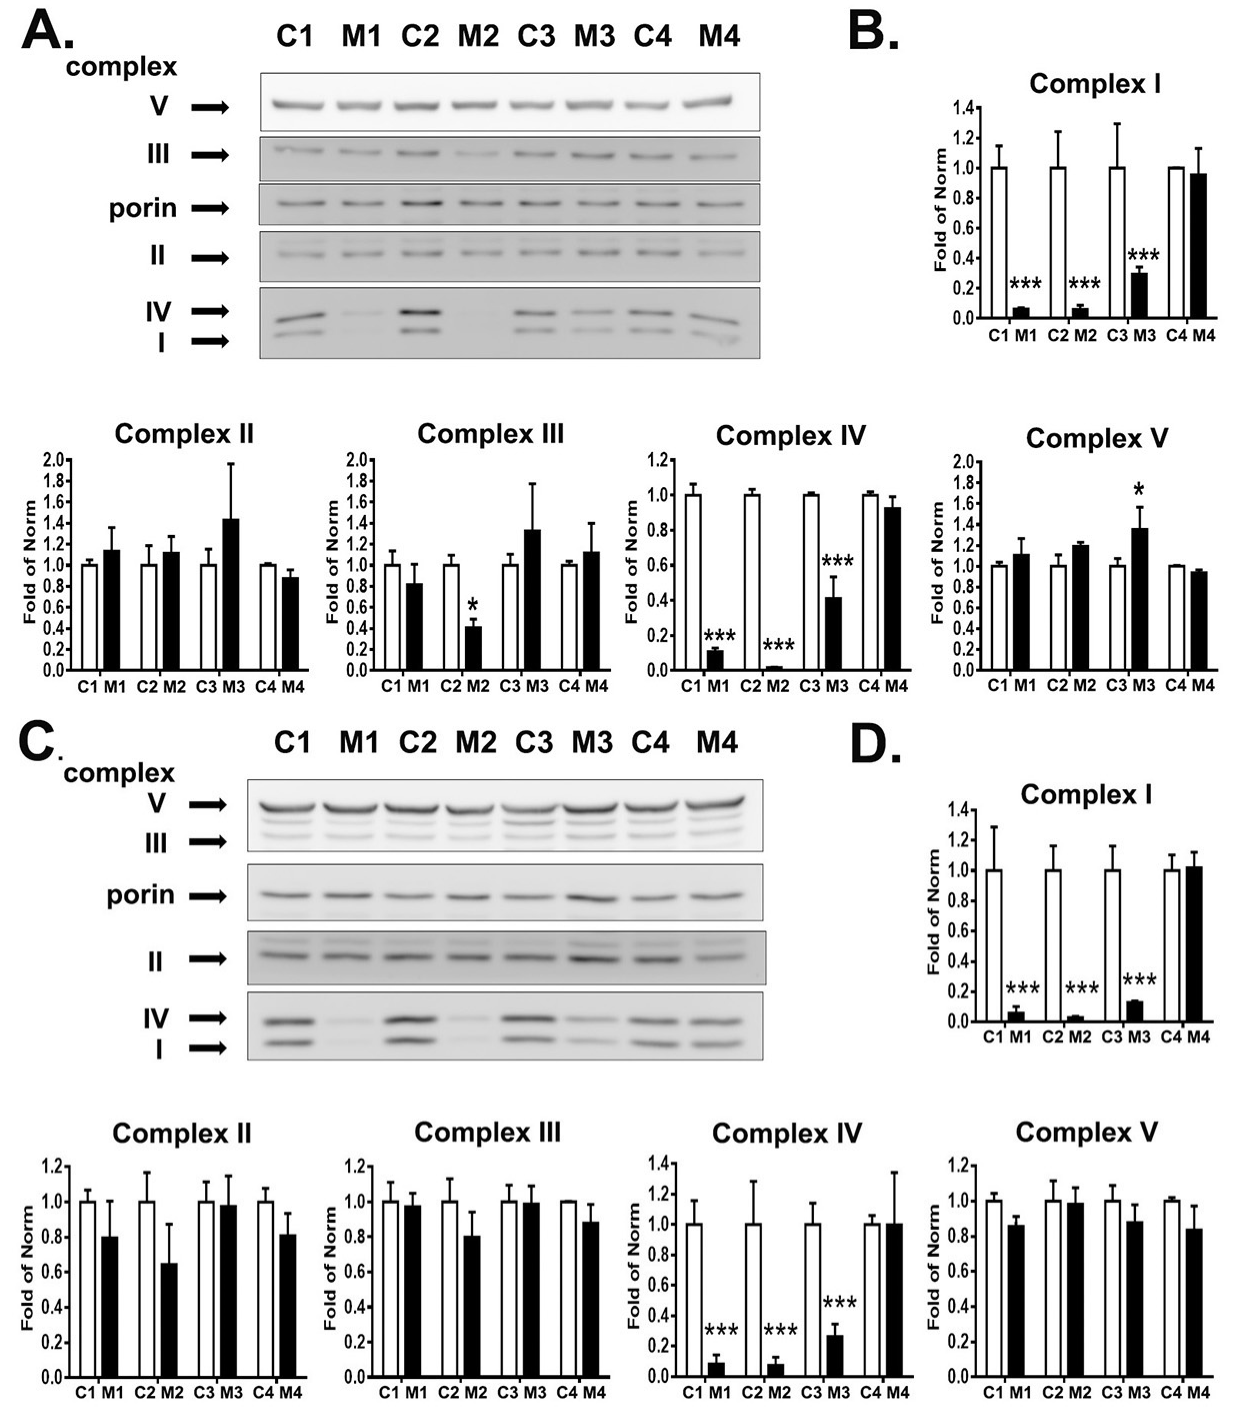
Figure 3. Expression of respiratory chain complexes in MELAS fibroblasts and MELAS iNs. ( A ) Western blotting analysis of respiratory chain complexes I–V in fibroblasts derived from controls (C1, C2, C3, C4) and MELAS (M1, M2, M3, M4) patients. ( B ) Quantification of respiratory complexes in fibroblasts after normalization to porin. Results are expressed as mean ± SD of three independent experiments. ( C ) Western blotting analysis of respiratory chain complexes I–V in iNs derived from control (C1, C2, C3, C4) and MELAS (M1, M2, M3, M4) fibroblasts. ( D ) Quantification of respiratory chain complexes in iNs after normalization to porin. Results are expressed as mean ± SD of three independent experiments. Statistical significance was calculated through two-way ANOVA. * p < 0.05 and *** p < 0.001 vs.